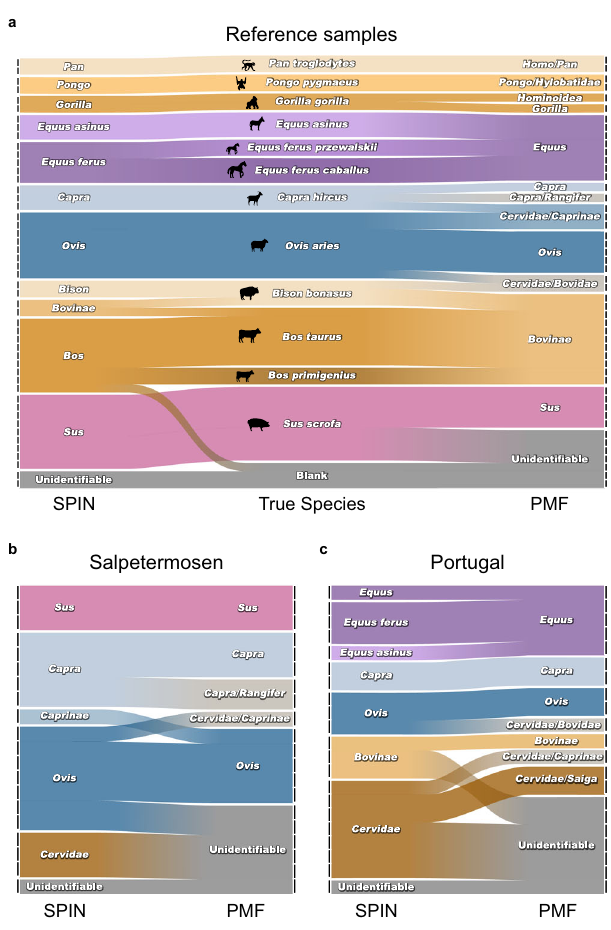
Fig. 6 Comparison of SPIN and PMF. a Alluvial diagram showing species identi fi cation of 46 reference bone samples and 3 laboratory blanks. Small bars on the x -axis indicate individual samples. Color and position in the middle column represent the true species, whereas the left and right column report the species identi fi cation by SPIN and PMF, respectively. Bars with color gradients indicate changing species assignments. b Alluvial diagram showing species identi fi cation of 20 representative samples from the Danish Salpetermosen site (Fig. 5). Left column indicates the species identi fi cation by SPIN, whereas the right column indicates the species identi fi ed by PMF. c Alluvial diagram showing species identi fi cation of 21 representative samples from the three Portuguese sites (Fig. 5). Left column indicates the species identi fi cation by SPIN, whereas the right column indicates the species identi fi ed by